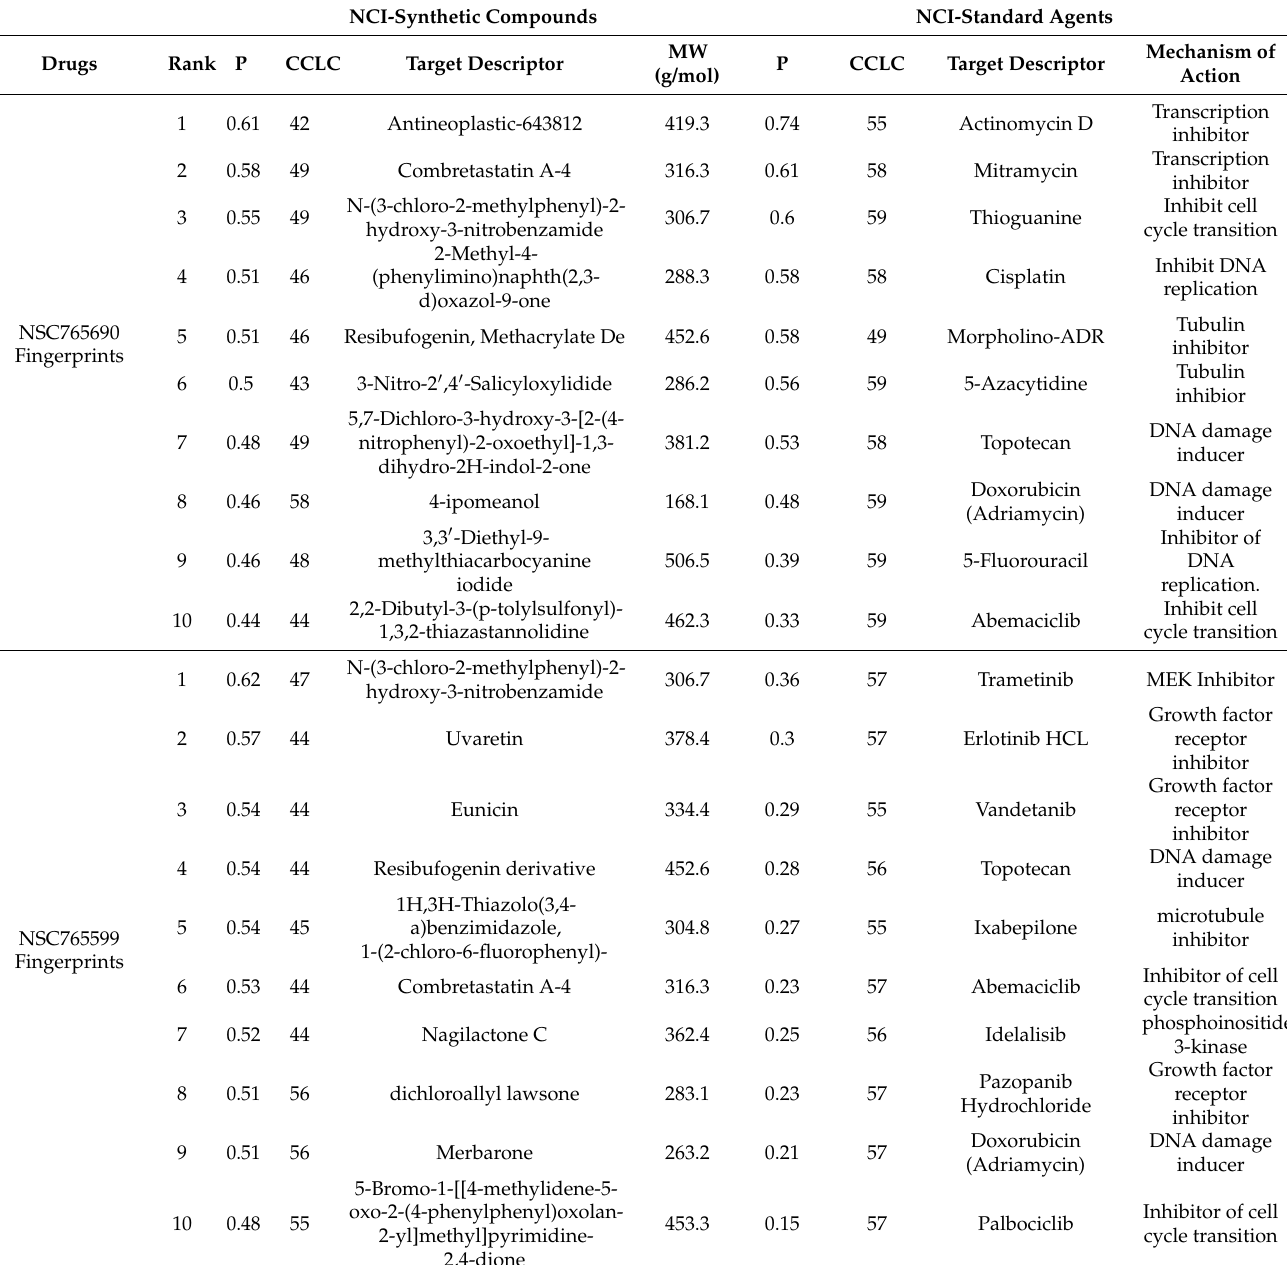
Table 2. NCI synthetic compounds and standard anticancer agent sharing similar anti-cancer fingerprints and mechanistic correlation with NSC765599 and NSC765690.